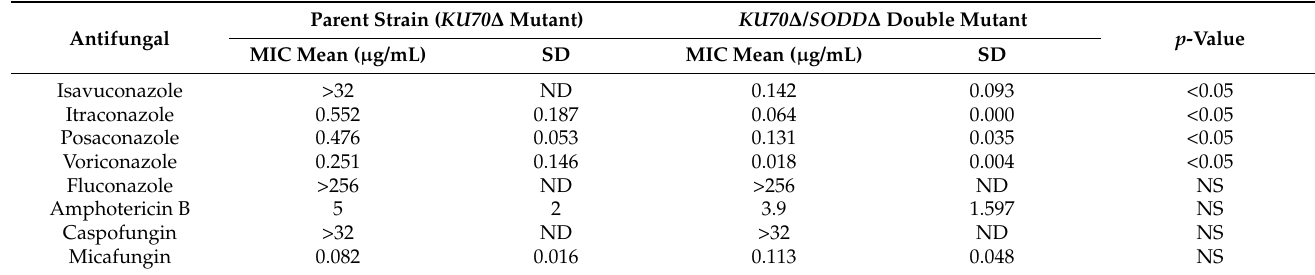
Table 2. In vitro susceptibility to